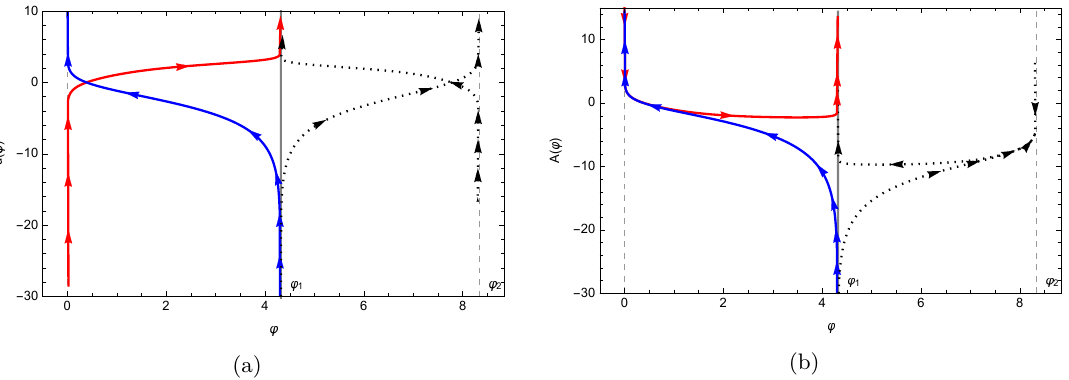
Figure 38 . The behavior of the holographic coordinate and scale factor in terms of ϕ for the and W L Min − flows. The red curve belongs to the W L Min + W L Min + 1 , 0 0 , 0 branch in figure W L Min − 0 , 0